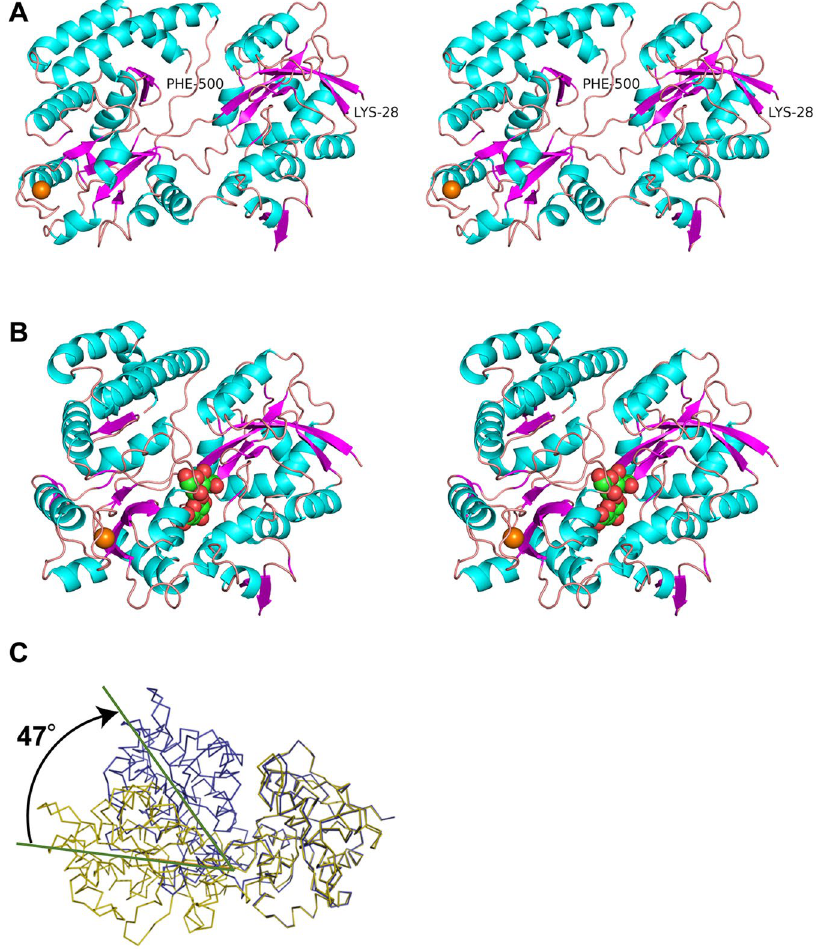
Figure 6. Overall structures of Smon0123. Structures (stereo-diagram with wall-eyed viewing) of ligand-free Smon0123 (N-28/C-5) ( A ) and C Δ 0S-bound Smon0123 (N-18/C-5) ( B ). Cyan, α -helices; purple, β -strands; pink, loops and coils. C Δ 0S bound to Smon0123 is shown in ball model (green, carbon atom; red, oxygen atom; and blue, nitrogen atom). Orange ball shows the metal ion. Structural comparison with ligand-free Smon0123 (N-28/C-5) (olive) and C Δ 0S-bound Smon0123 (N-18/C-5) (blue) ( C ). Both N-domains of ligand-free and -bound Smon0123 proteins were superimposed. There is a structural difference (47° in angle) in the N- and C-domains between C ∆ 0S-free and -bound